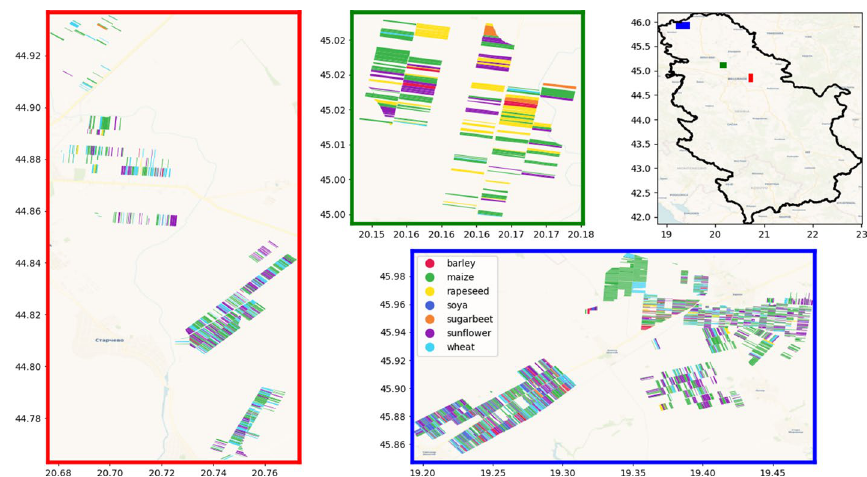
Fig. 1 Locations of crop labels in